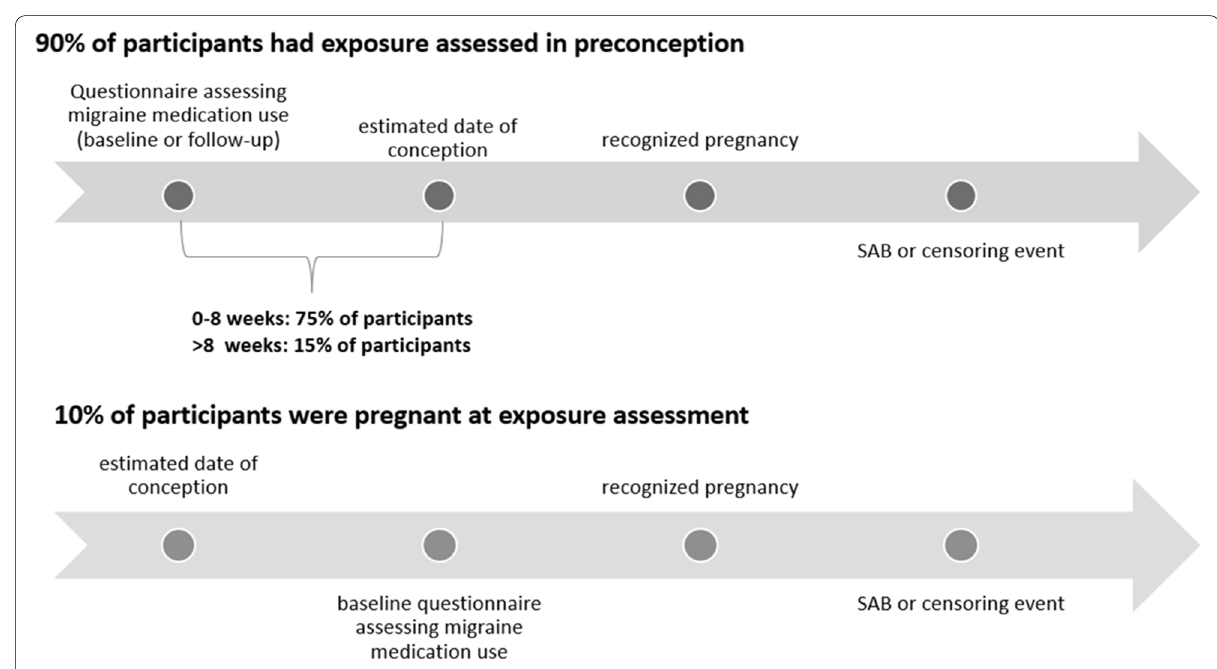
Fig. 2 Assessment of migraine medication use relative to exposure.